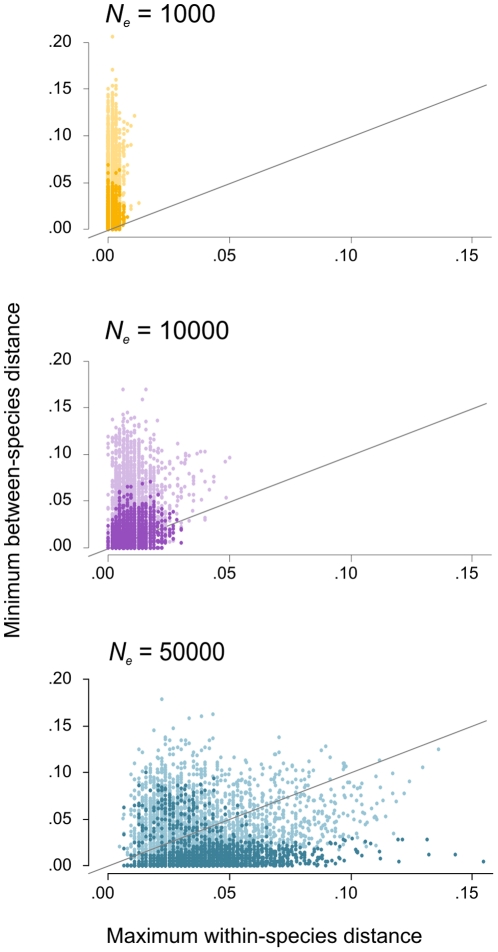
Species ‘barcode gap’.Scatterplots of minimum between- over maximum within-species distance for 5000 simulated species in the reference data sets with 16 samples per species. Simulations under coalescence with effective population sizes (Ne) of 1000 (yellow, top), 10000 (purple, middle) and 50000 (blue, down) individuals. Brightness of the dots correlates with species divergence times, i.e. recently diverged species are dark and old species are light. Species plotted above the diagonal lines have a barcode gap.